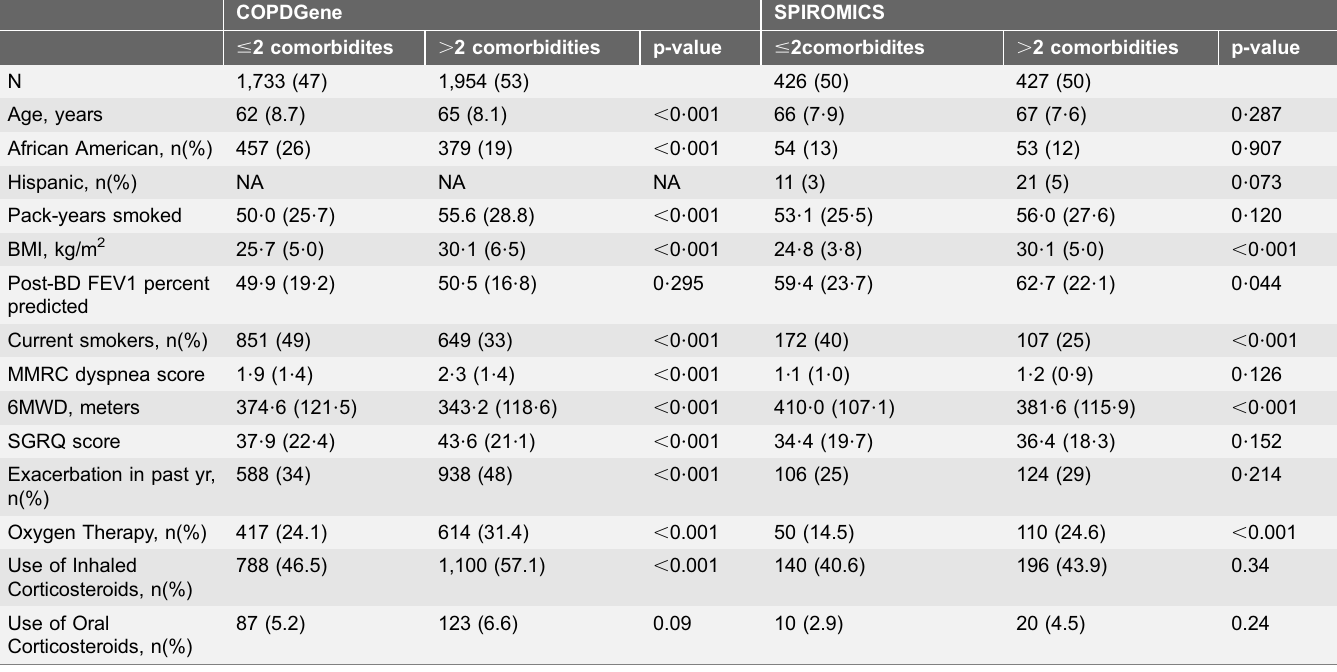
Table 1. Characteristics of participants with COPD based upon number of